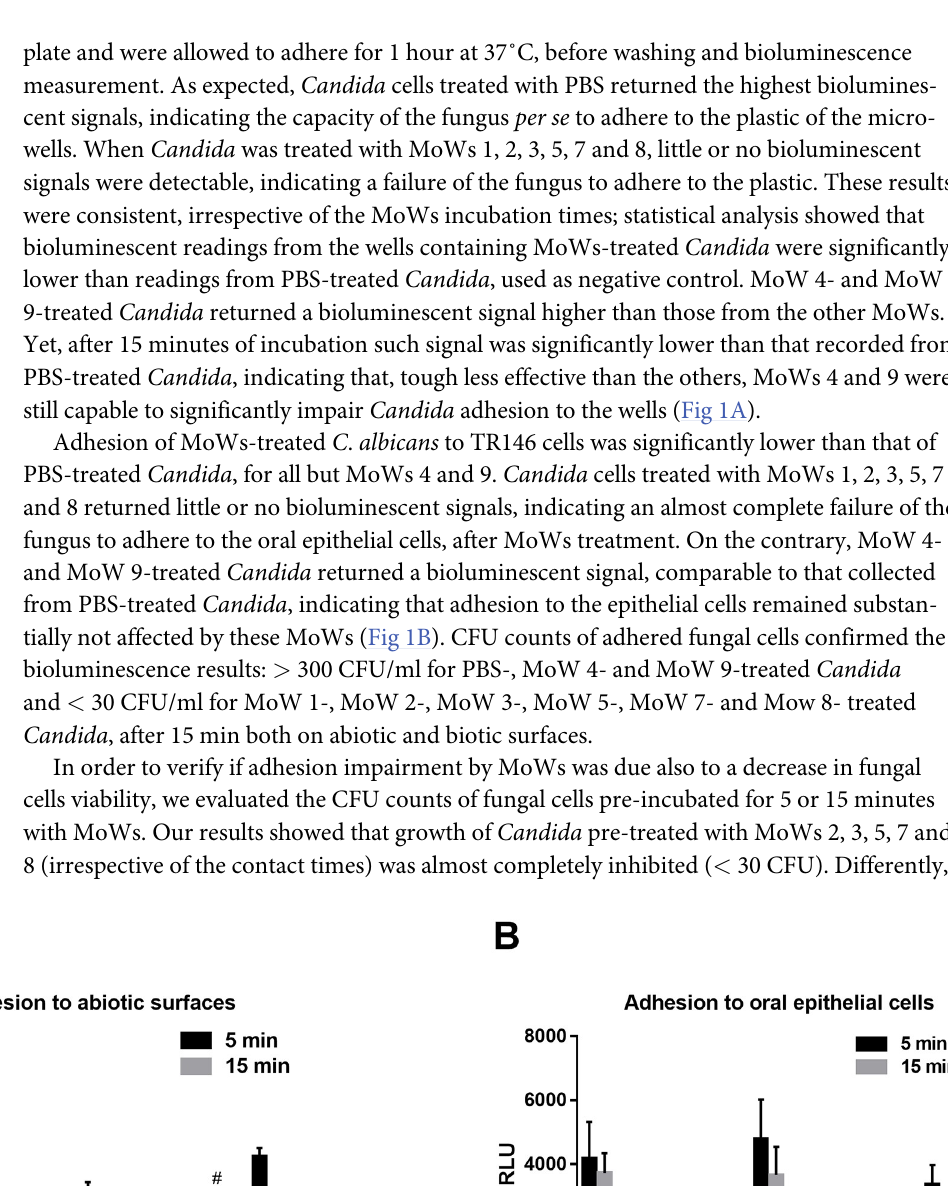
PLOS ONE | https://doi.org/10.1371/journal.pone.0207262 November15,